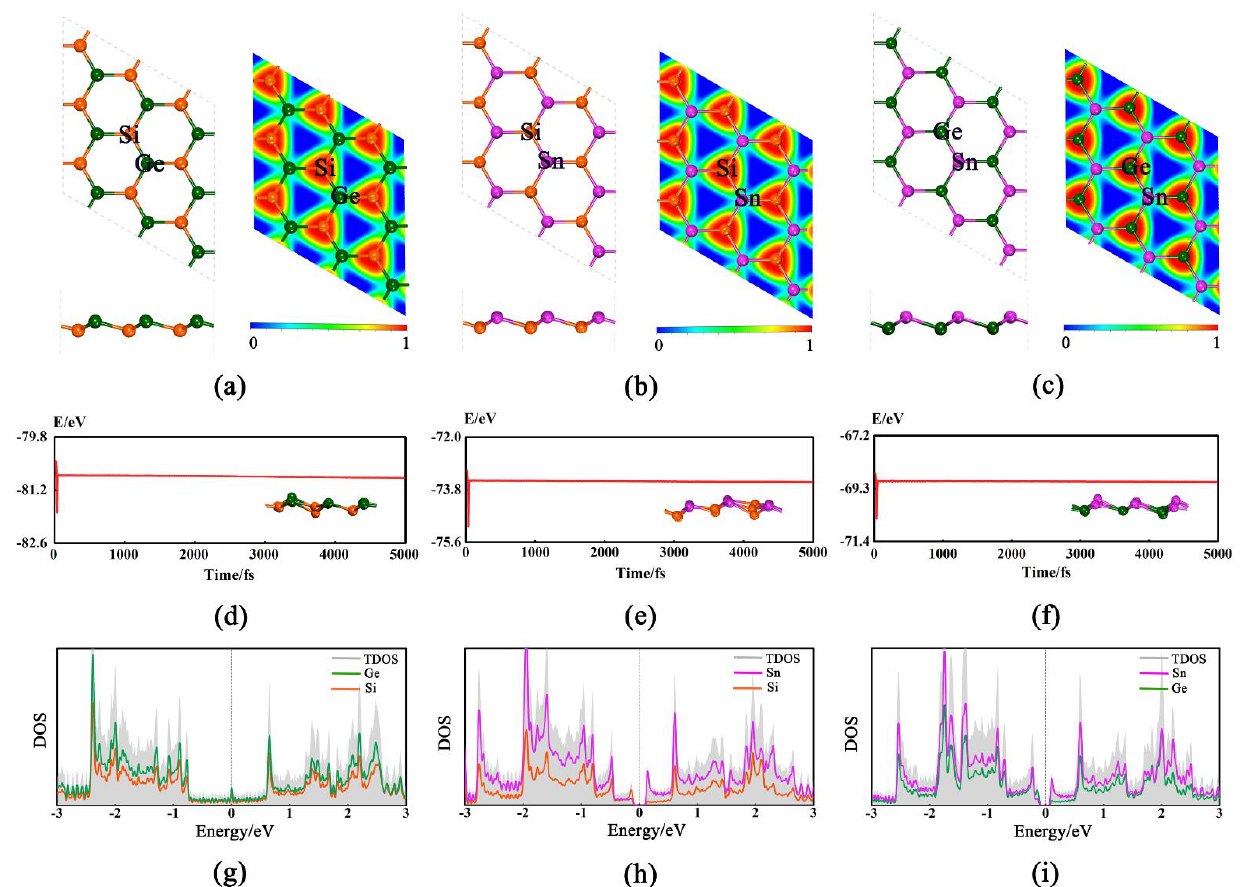
Figure 1. Optimized structures (top and side views) and electron location function (ELF) for GeSi ( a ), SnSi ( b ), and SnGe ( c ). The Si, Ge, and Sn atoms are represented by orange, dark green, and purple balls, respectively. The trajectory of ab initio molecular dynamic simulation at 500 K (the final corresponding structure snapshot is given in inset) of GeSi ( d ), SnSi ( e ), and SnGe ( f ). The density of states (DOS) for GeSi ( g ), SnSi ( h ), and SnGe ( i ).